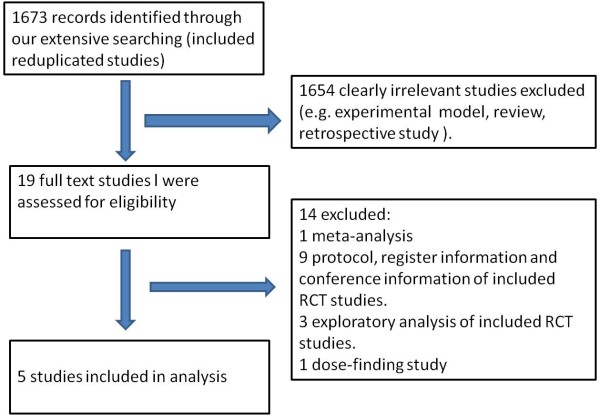
Flow diagram for study selection. RCT, randomized controlled trial.